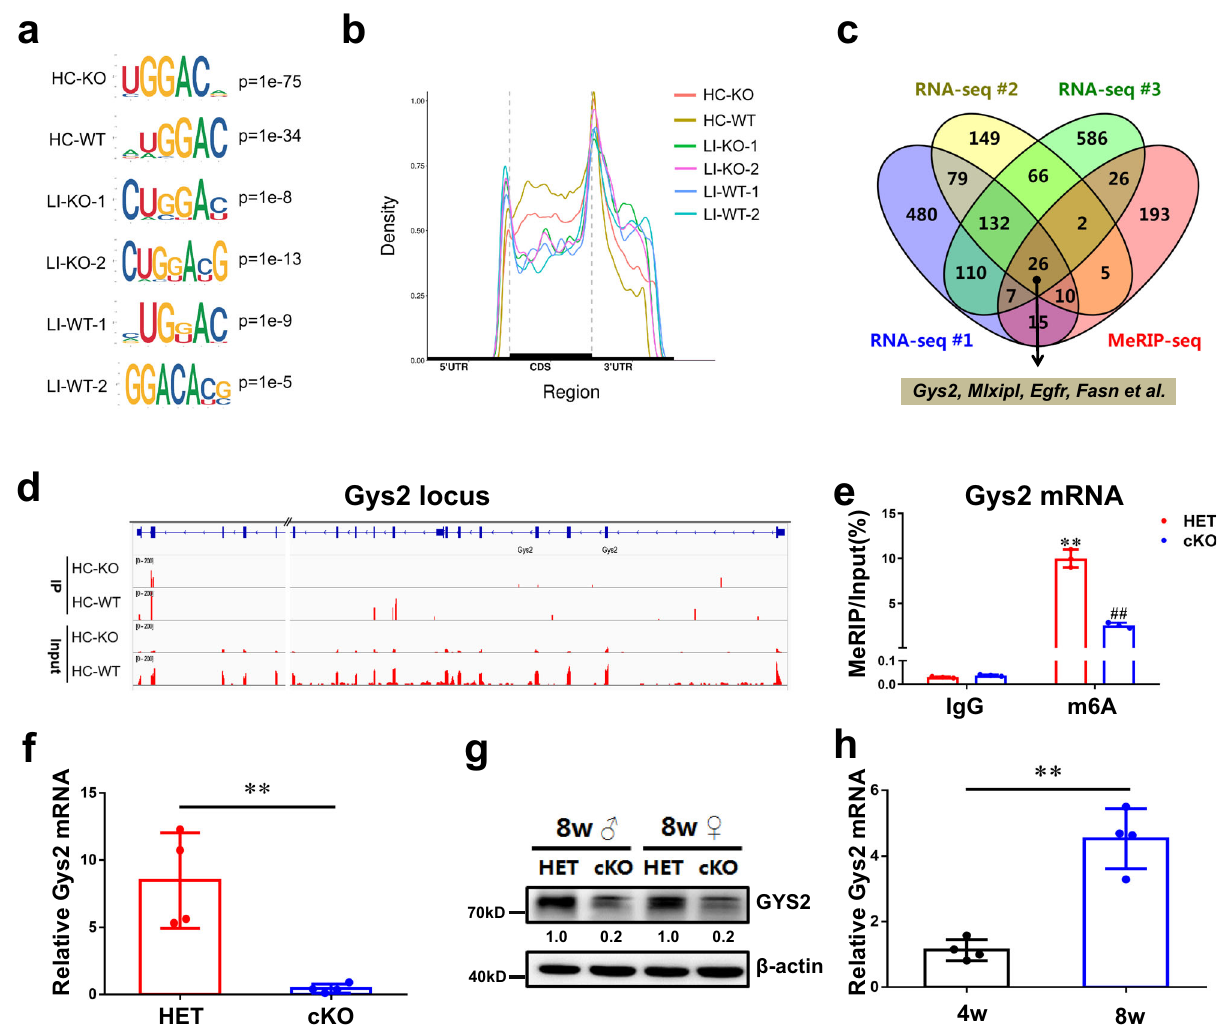
Fig. 3 | Identi fi cation of Gys2 mRNA by global N6-methyladenosine modi fi ca- tionanalysisasakeysubstrateofMETTL3inmouseliver.a The most enriched sequence motif of m6A peaks in mRNAs from 8-week-old WT or cKO mouse hepatocytes (HC) or liver (LI) samples. b Distribution of m6A peaks along the 5 ′ UTR, CDS, and 3 ′ UTR regions of total mRNAs from 8-week-old mouse sam- ples after normalized with length. c RNA-Seq and MeRIP-Seq identi fi ed downregulated and m6A-lost genes in Mettl3 -cKO liver tissue or hepatocytes comparing to wild-type samples. All the samples were from 8-week-old mice. MeRIP-seq data were from hepatocytes of male mice; RNA-seq data were from hepatocytes and liver tissues of male mice and liver tissues of female mice, respectively. d m6A MeRIP-Seq revealed the location of speci fi c m6A peak in Gys2 locus in hepatocytes of wildtype or Mettl3-cKO mice. //, deletion of a long and uninformative intron for better exhibition. e m6A enrichment of Gys2 mRNA in mettl3 -HET or cKO hepatocytes by m6A-RIP-qPCR. n = 3 independent